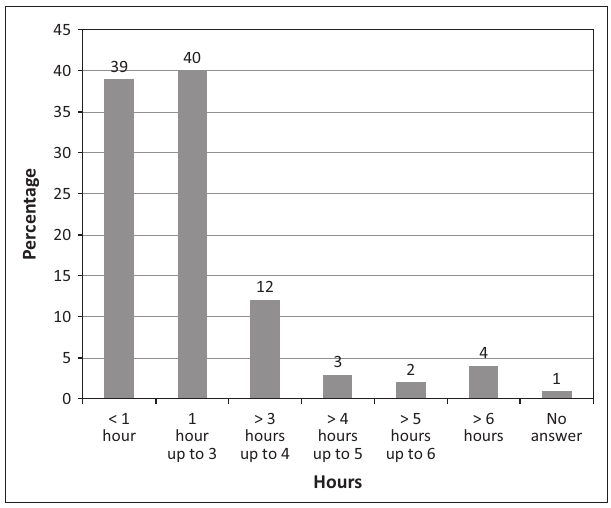
FIGURE 2: The number of hours spent on Facebook